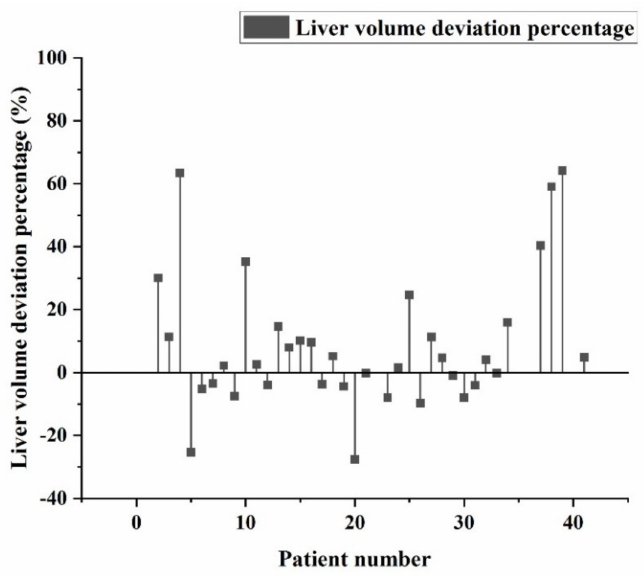
Figure 10. Percentage error between pathological data and identification data for individual